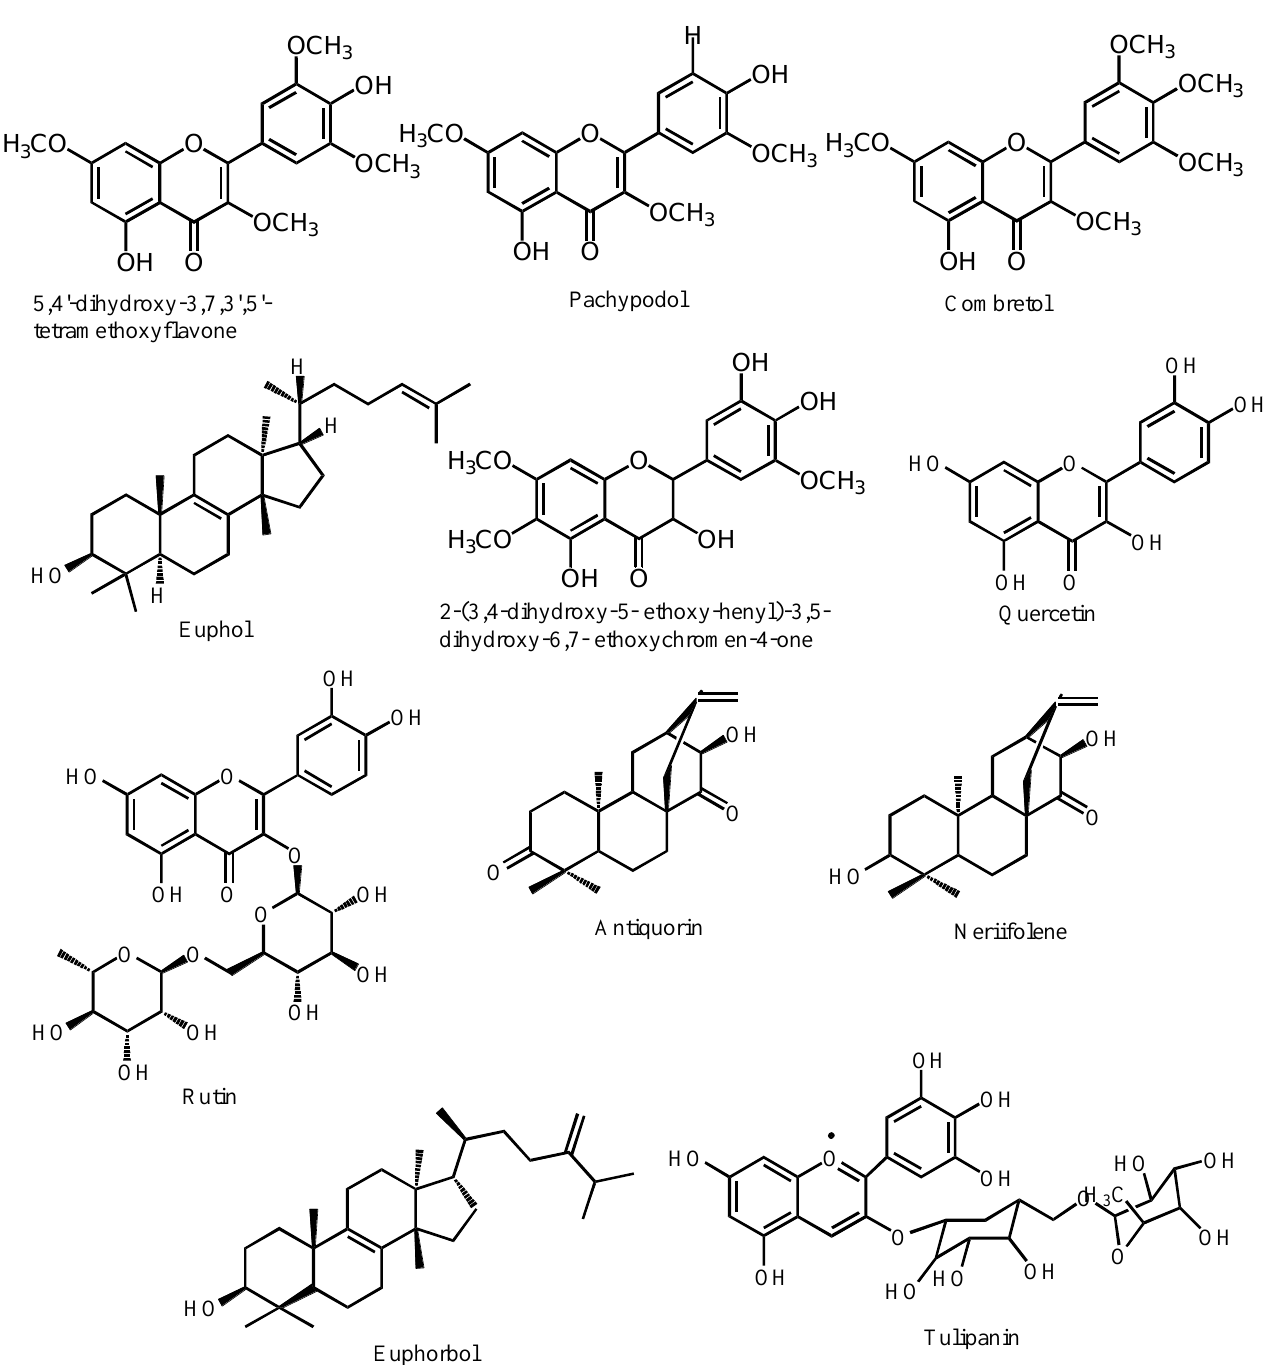
Figure 2. Major characteristic phytoconstituents found in E. neriifolia . Diterpenes and triterpenes are the major compounds obtained from Euphorbia spe- cies. A new tetracyclic triterpene nerifoliene along with neriifoliol, nerifolione, euphol,